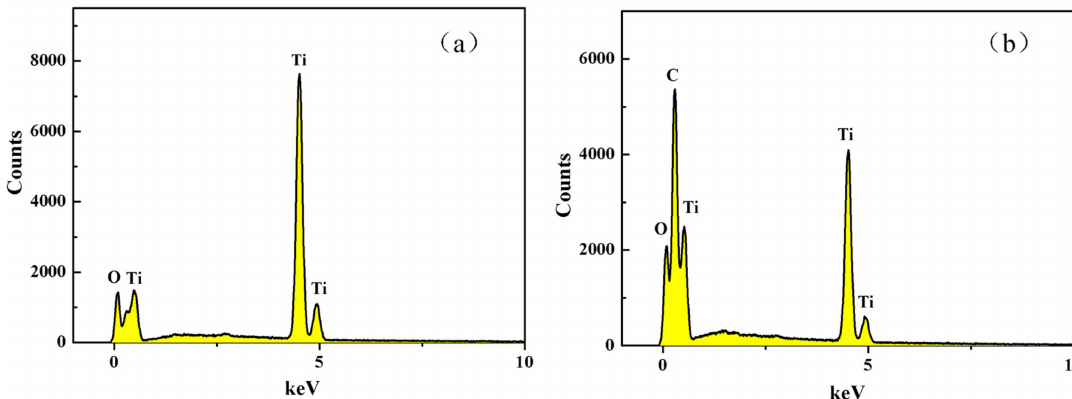
Figure 3. EDS images of P25 ( a ) and RGO-P25 ( b